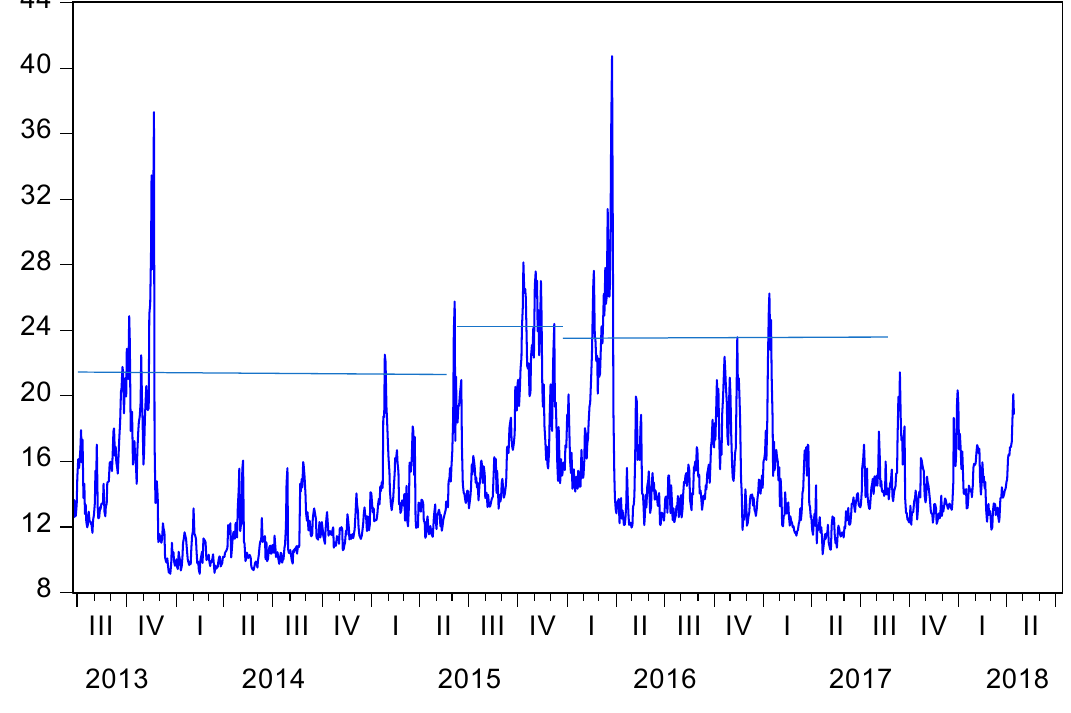
Figure 3. VIX and major breaks.